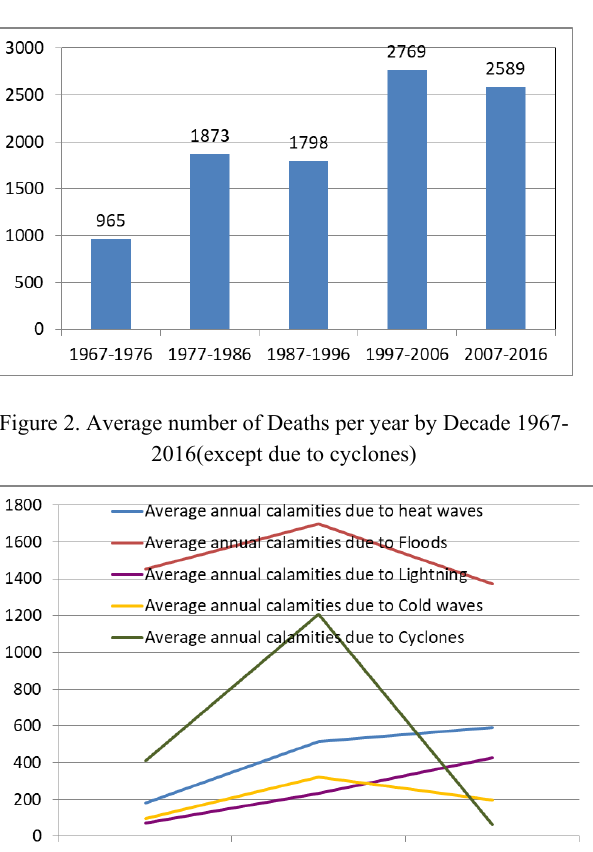
Figure 3. Average annual calamities due to different